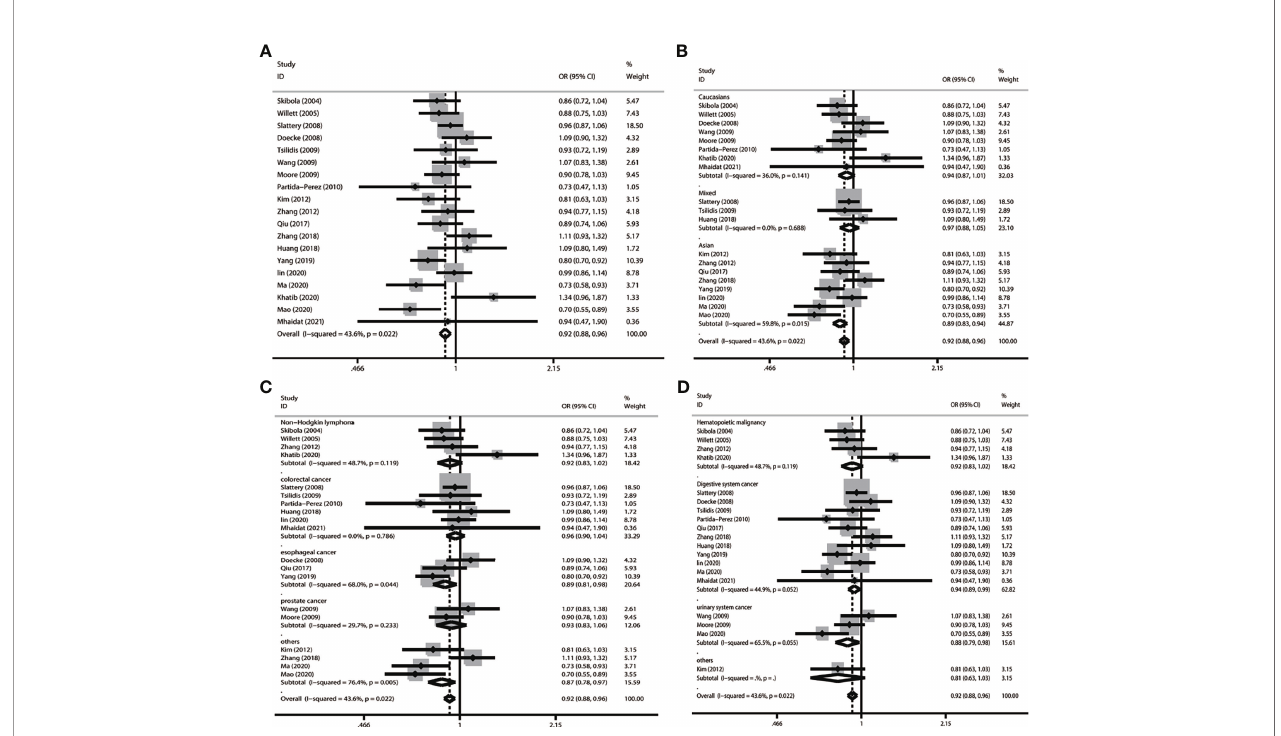
FIGURE 2 | Forest plot of subgroup analysis of LEP G19A and cancer risk in the allele model (A vs. G) (A) LEP G19A polymorphism and overall cancer risk; (B) LEP G19A polymorphism and cancer risk on ethnicity; (C) LEP G19A polymorphism and risk of cancer type; (D) LEP G19A polymorphism and the risk of cancer system).